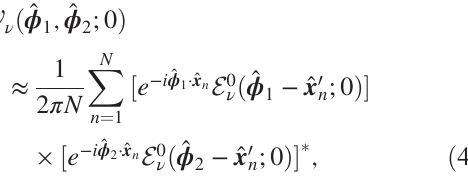
compares the performance of